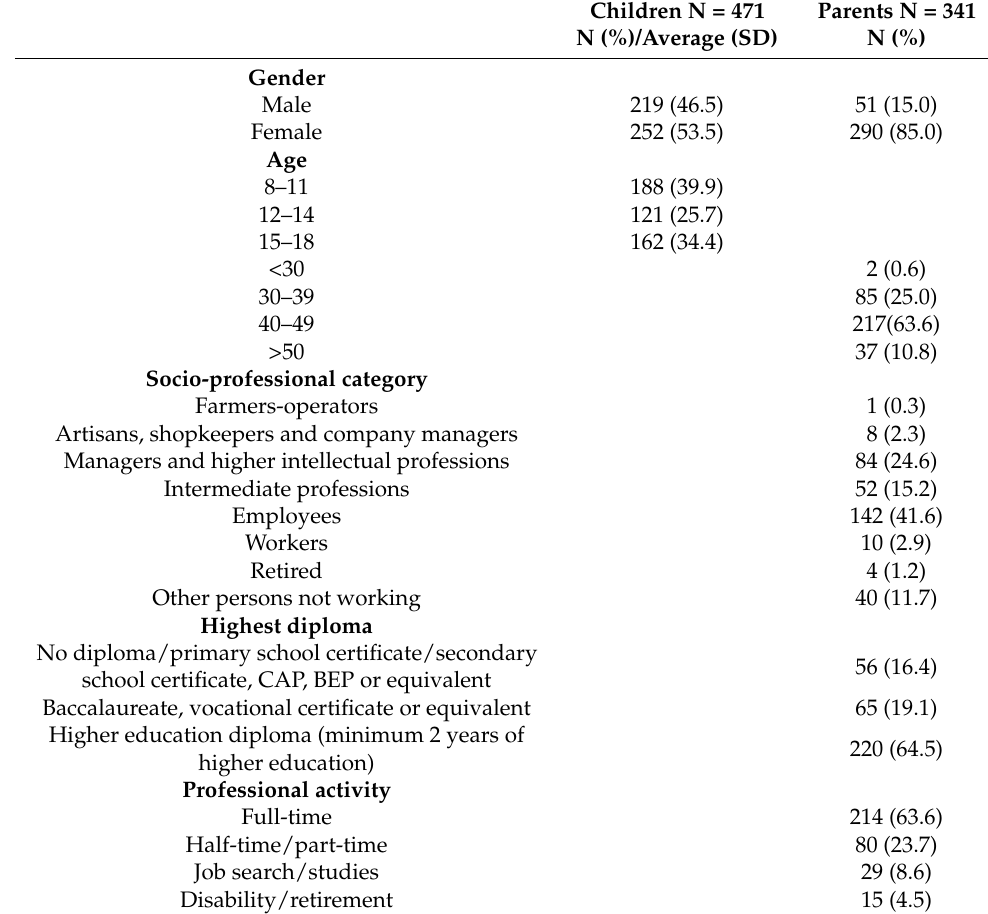
Table 1. Socio-demographic characteristics of parents and